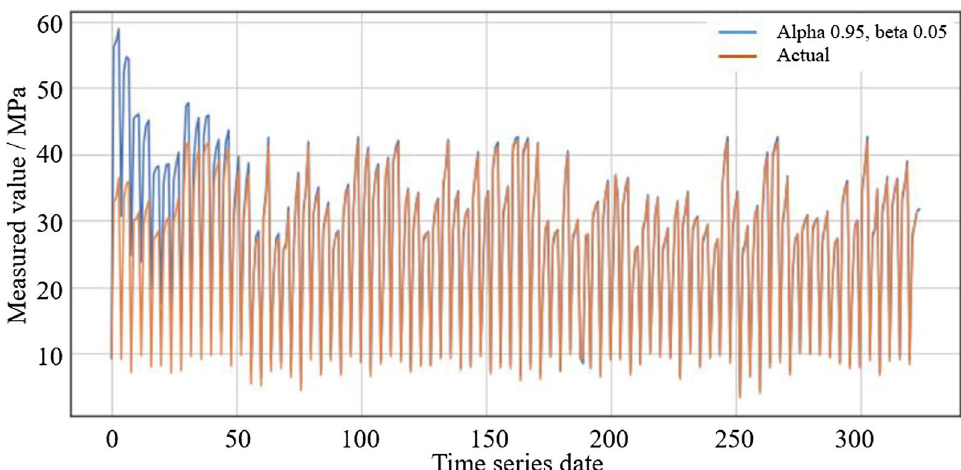
Fig. 7 Support load predictions based on the double exponential smoothing